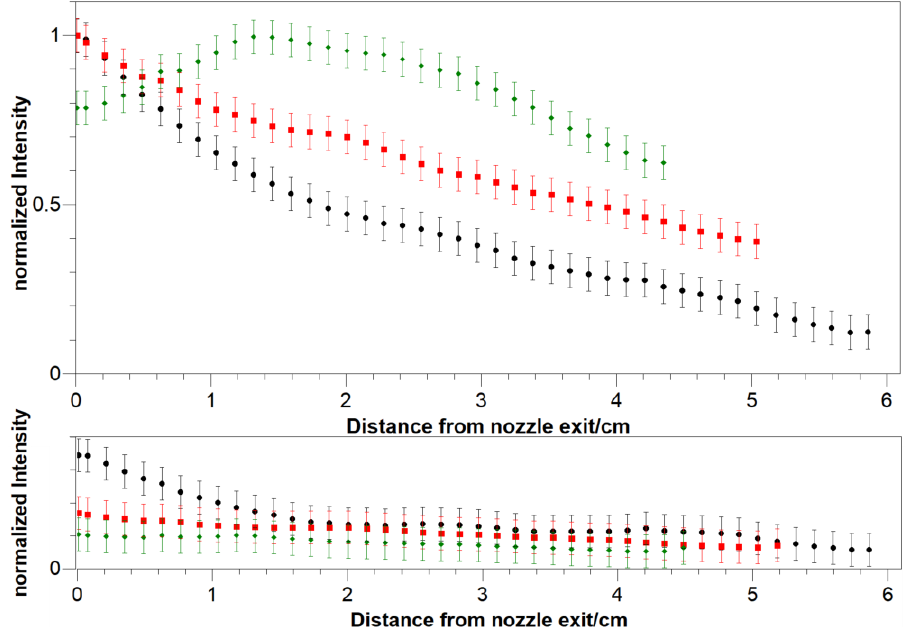
Figure 6. Intensity distribution at the centroid frequency ( upper ) and average over all frequen- cies ( lower ) for the best parameters of the low-stagnation-pressure nozzle (black, P 0 = 80.6 mbar, P = 5.6 × 10 − 3 mbar), mid-range nozzle (red, P 0 = 125 mbar, P = 7.35 × 10 − 3 mbar) and high- stagnation-pressure nozzle (green, P 0 = 125 mbar, P = 9.3 × 10 − 3